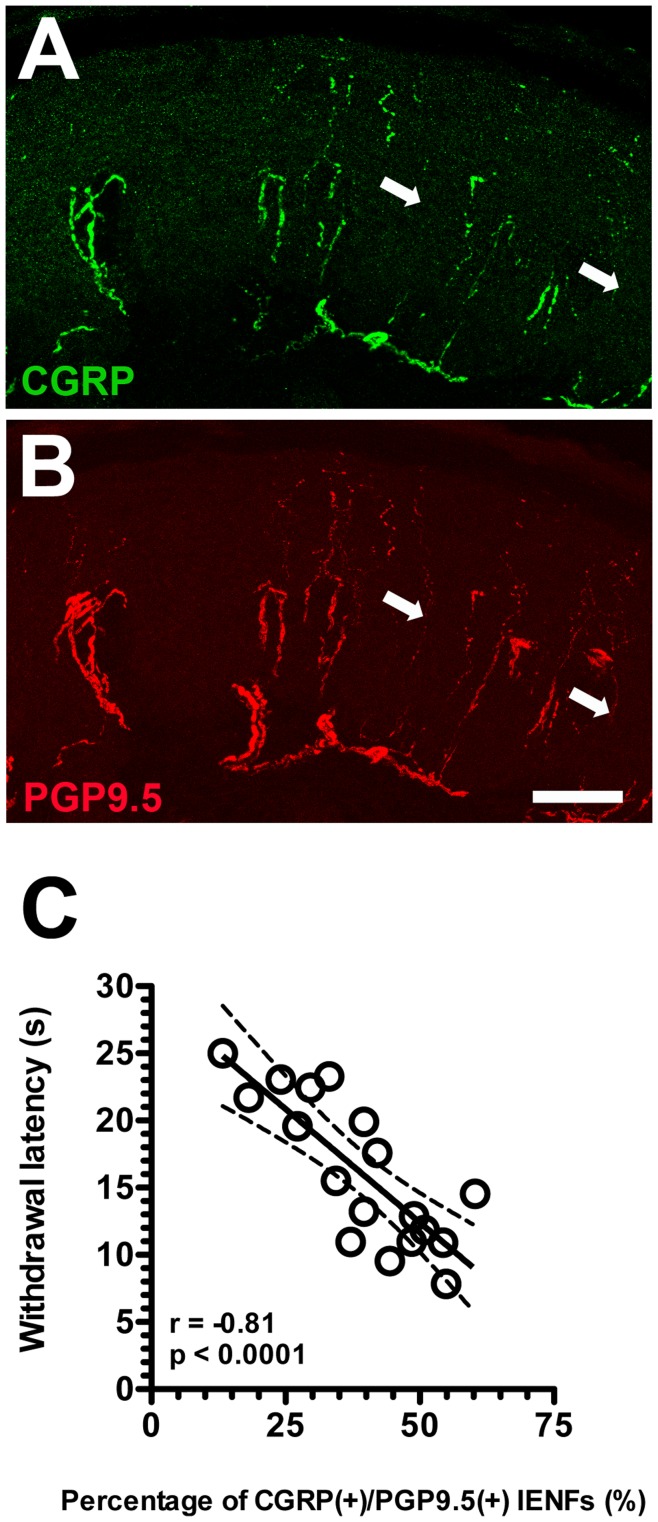
Colocalization of calcitonin gene-related peptide (CGRP) and protein gene product 9.5 (PGP9.5) in intraepidermal nerve fibers (IENFs) and the relationship with hot-plate latencies in resiniferatoxin (RTX)-induced neuropathy.(A, B) The graphs shows the double-labeling of CGRP(+) (A, in green) and PGP9.5(+) IENFs (B, in red) in the vehicle group. CGRP(+) IENFs were colocalized with PGP9.5(+) IENFs and some of PGP9.5(+) IENFs were CGRP(−) IENFs (arrow in A). (C) The graph shows the correlation of CGRP(+)/PGP9.5(+) IENFs with withdrawal latency on hot-plate test in RTX-induced neuropathy. Bar, 50 µm.